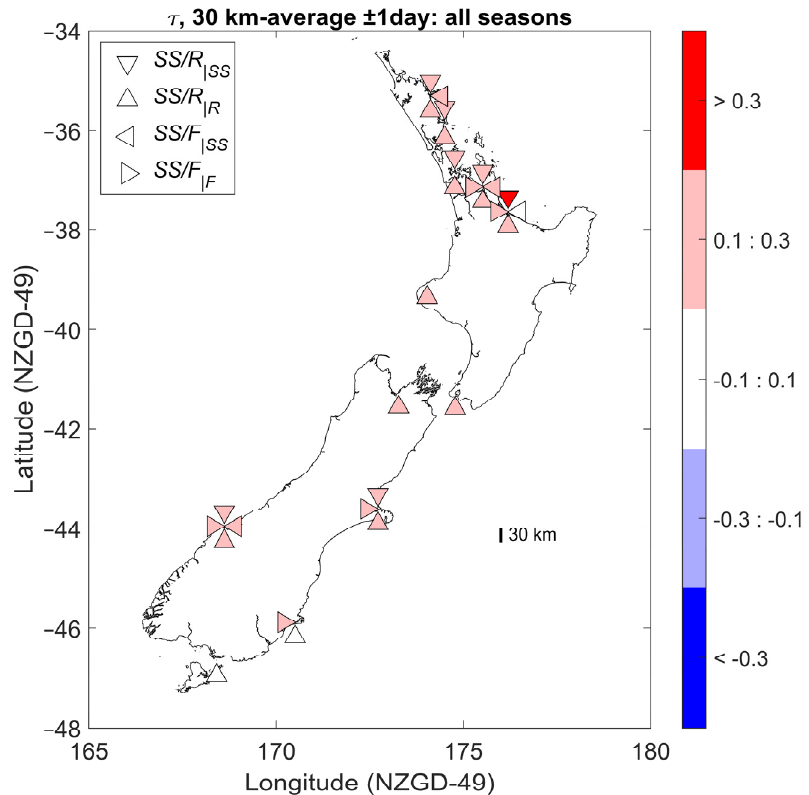
Figure 4. Kendall’s rank correlation coefficient τ (color scale) averaged within 30 km of sea-level gauge for four cases (Table 1). Only correlations with a p -value of ≤ 0.05 were plotted; hence, not all cases are represented at all sites.